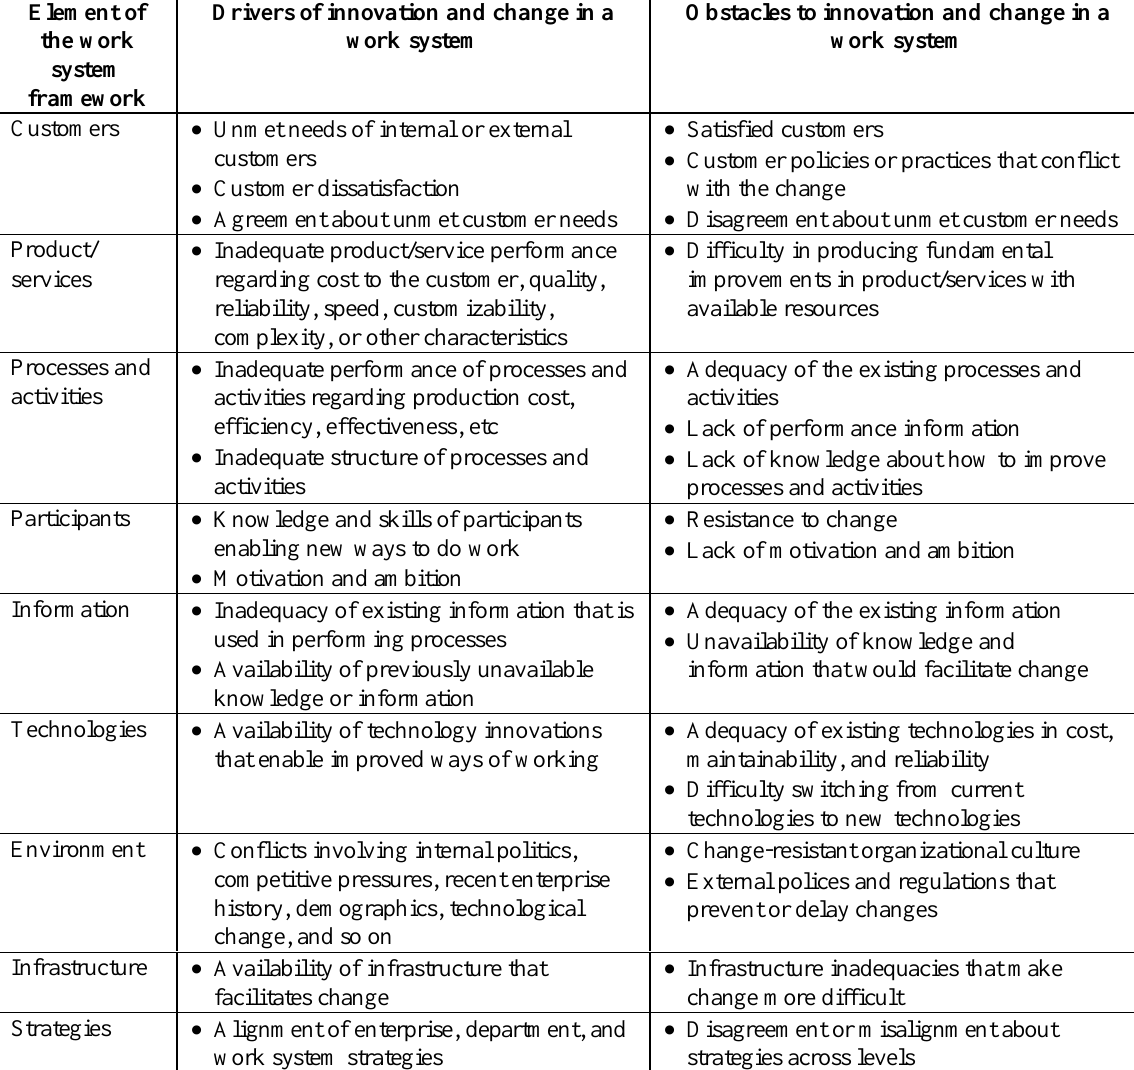
Table 3. Drivers and obstacles to work system change organized using the work system framework Element